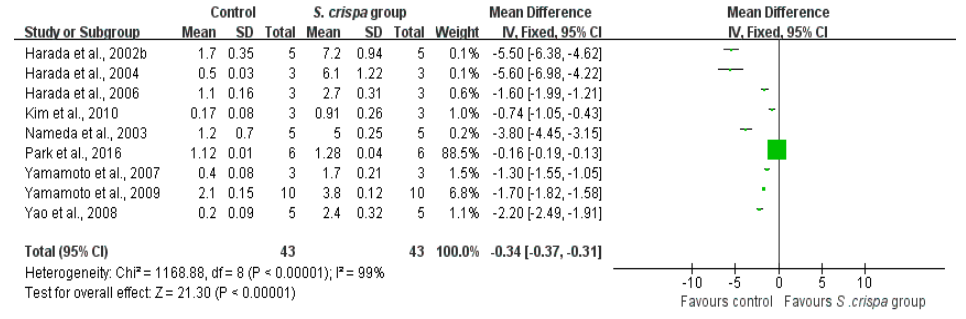
Figure 5. Comparison of levels of tumor activity between control and S. crispa groups. ( ): SMD of individual studies; (  ): summary SMDs of the comparison.